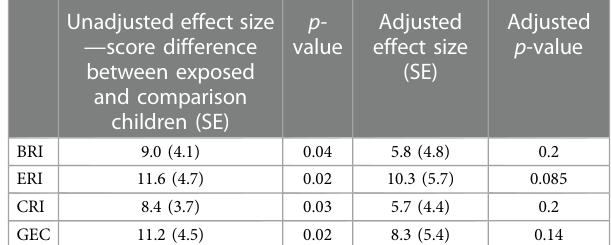
TABLE 5 Regression parameters: association of methadone exposure with BRIEF ® 2 scores before (unadjusted) and after (adjusted) controlling for maternal tobacco